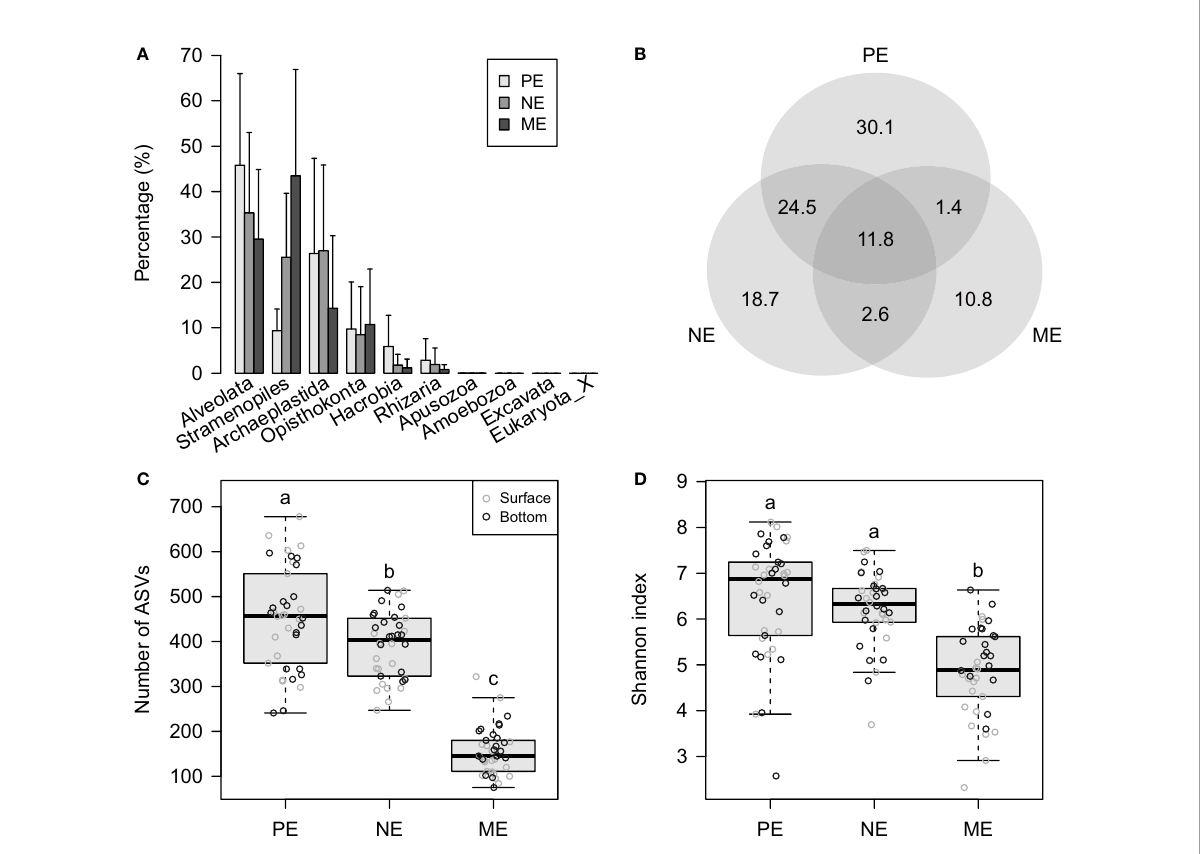
FIGURE 2 (A) Bar graph showing the percentage mean (and standard deviation) relative abundance of the various supergroups, based on the full ASV-sample table. (B) Venn diagram showing the percentage of ASVs that are unique in, and shared among, the PE, NE, and ME categories. (C, D) Boxplots showing the (C) observed ASV numbers and (D) Shannon indices using the rari fi ed ASV-sample table. In (C) and (D) , the letters above each boxplot indicate signi fi cant differences at p <